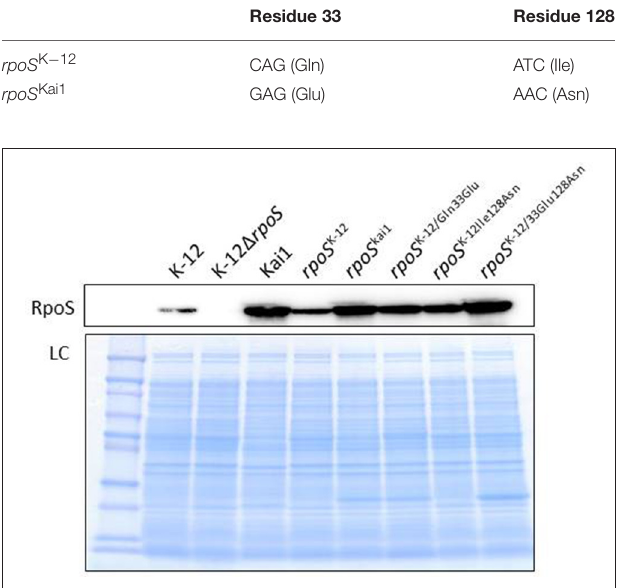
FIGURE 2 | Effect of substitution at residue 128 on RpoS activity. RpoS activity in rpoS variants was determined by HPII activity assays and analysis of glycogen levels, which are positively regulated by RpoS. (A) HPII activity in rpoS variants was measured by HPII assays. (B) Glycogen levels in rpoS variants were measured by glycogen assays. Mean values are shown ( n = 3). Error bars represent standard deviations. The statistical significance of the differences is tabulated in Tables S1,